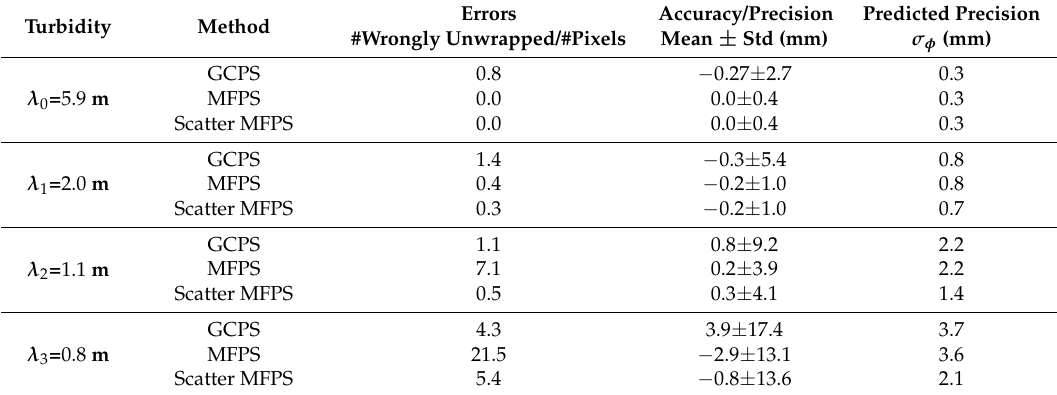
Table 1. Errors in third column are defined as percentage of pixels with error larger than ± 2 π phase of the reference plane in the area shown in Figure 11. The accuracy and precision in the fourth column is defined as the mean and standard deviation (in millimeters) of the difference between the measured distance and the ground truth over a 100 × 100 area in the middle of the area shown in Figure 11. The predicted precision is computed using Equation